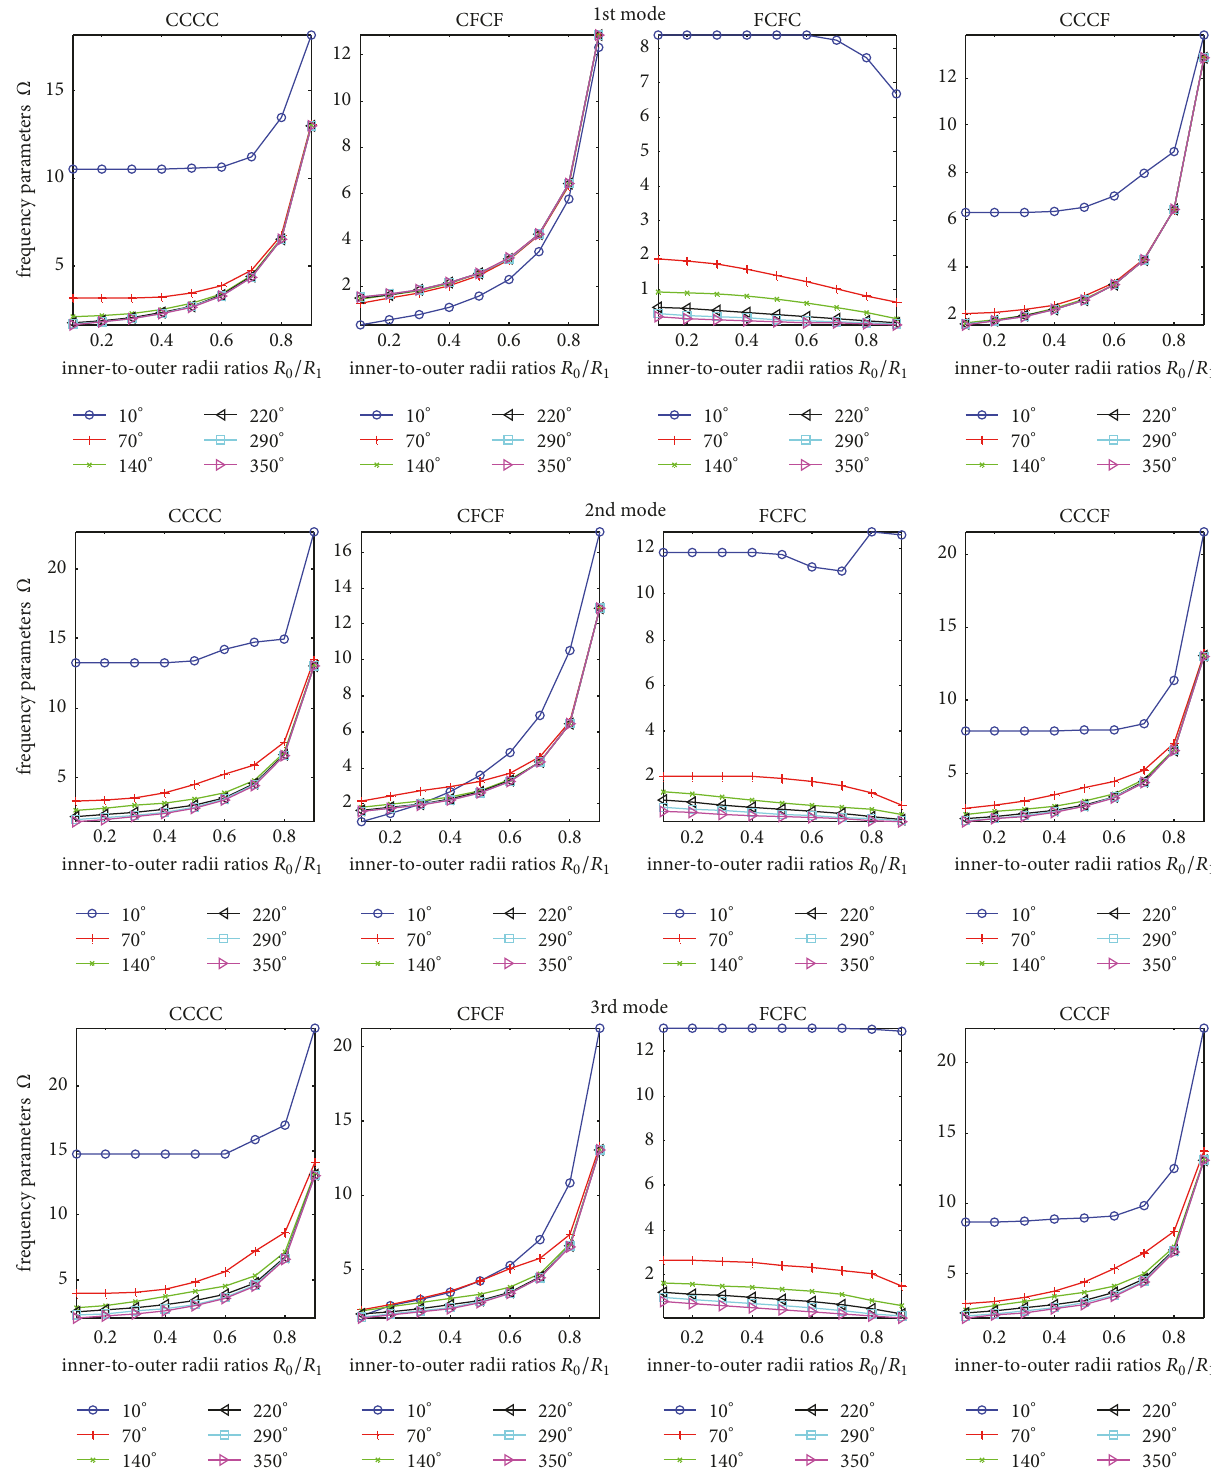
Figure 13: The variation of first three frequency parameters for the annular sector plate with different boundary conditions, inner-to-outer radii ratios, and sector